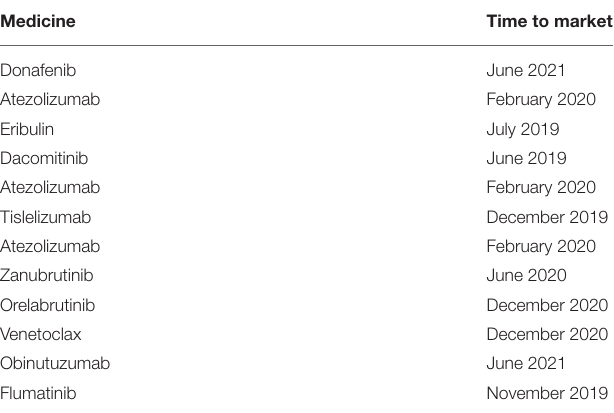
TABLE 9 | Oncology meidicines marketed in China in 2019 and later in the above table.